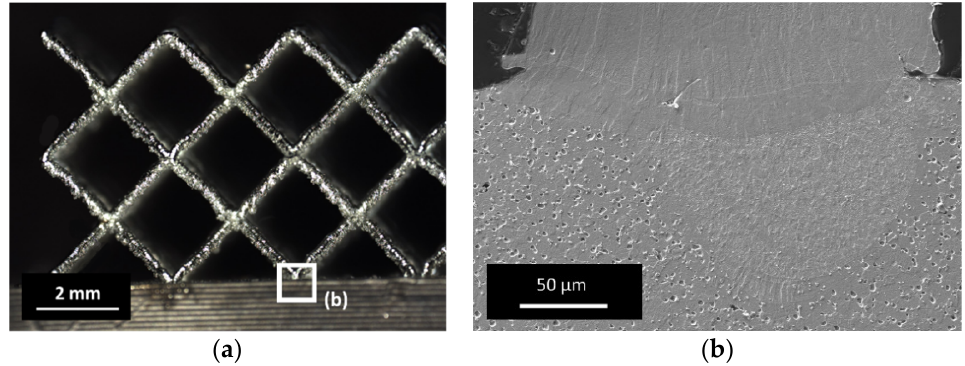
Figure 14. ( a ) Micrograph of filigree bcc lattice structure ( Φ 300 µm); ( b ) SEM micrograph of the interface of FFF part (lower part) and LPBF lattice structure (upper part), surface was etched after Kroll.